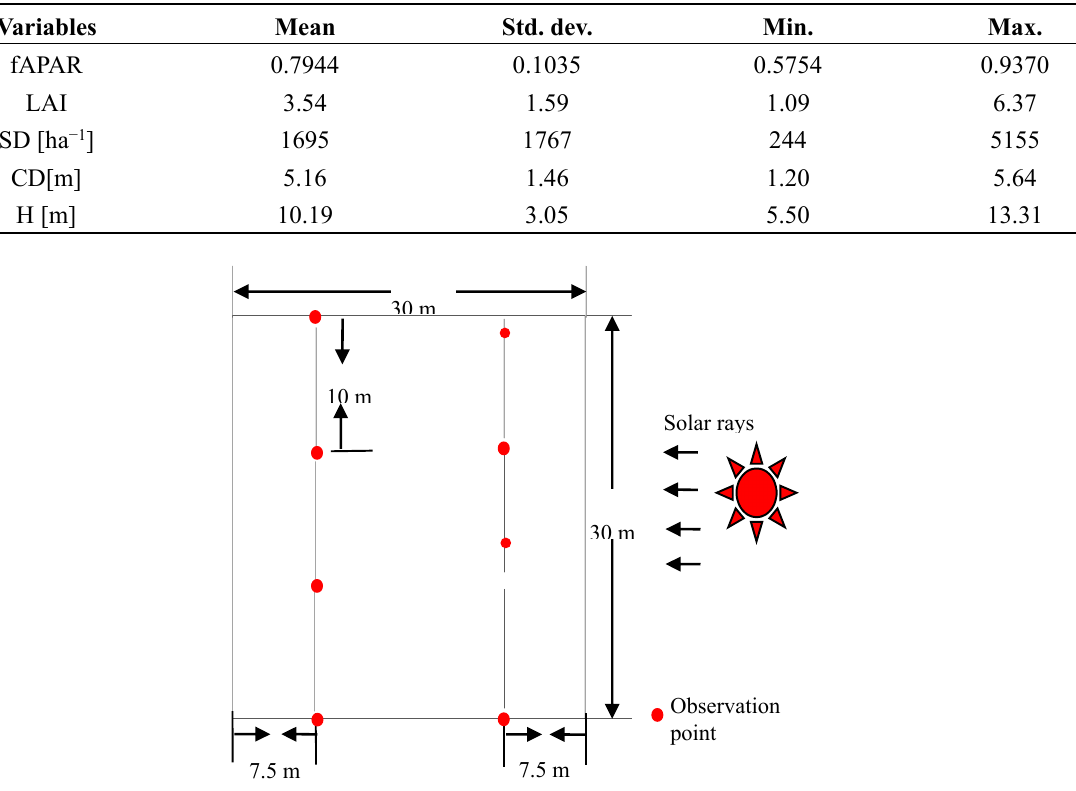
Figure 3. Sampling scheme for TRAC transects and LAI-2200 measurement points. The distance between two LAI measurement points was ten meters in each cardinal